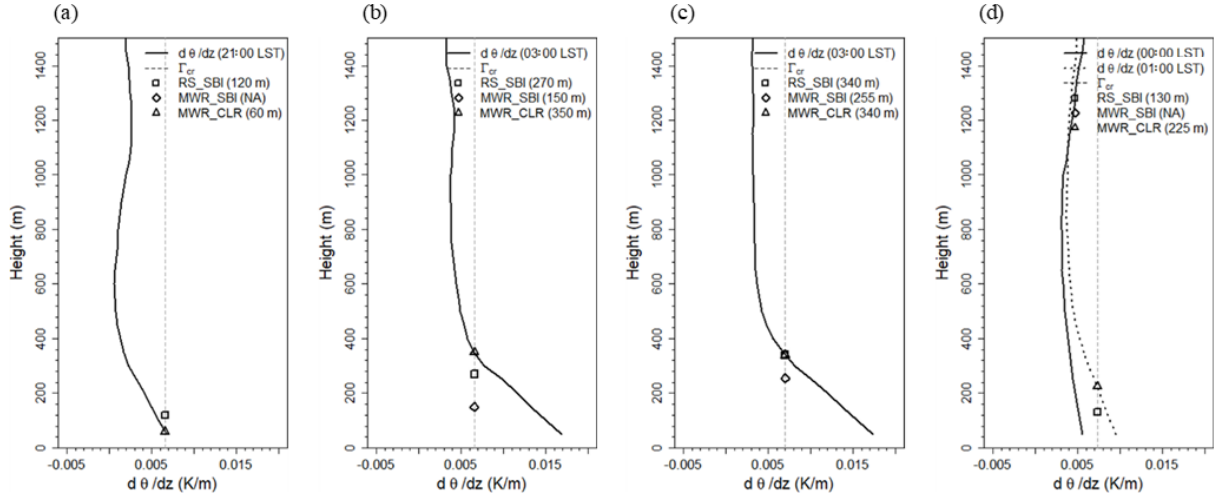
Figure 5. Vertical profiles of potential temperature, threshold of lapse rate ( (cid:48) cr ), and the SBLHs estimated by the radiosonde and the MWR at (a) 21:00LST on 22 September 2016, (b) 03:00LST on 23 September 2016, (c) 03:00LST on 24 September 2016, and (d) 00:00LST on 27 September 2016. The SBI method was applied to two measurements (RS_SBI, MWR_SBI), while the CLR method was applied to the MWR (MWR_CLR).